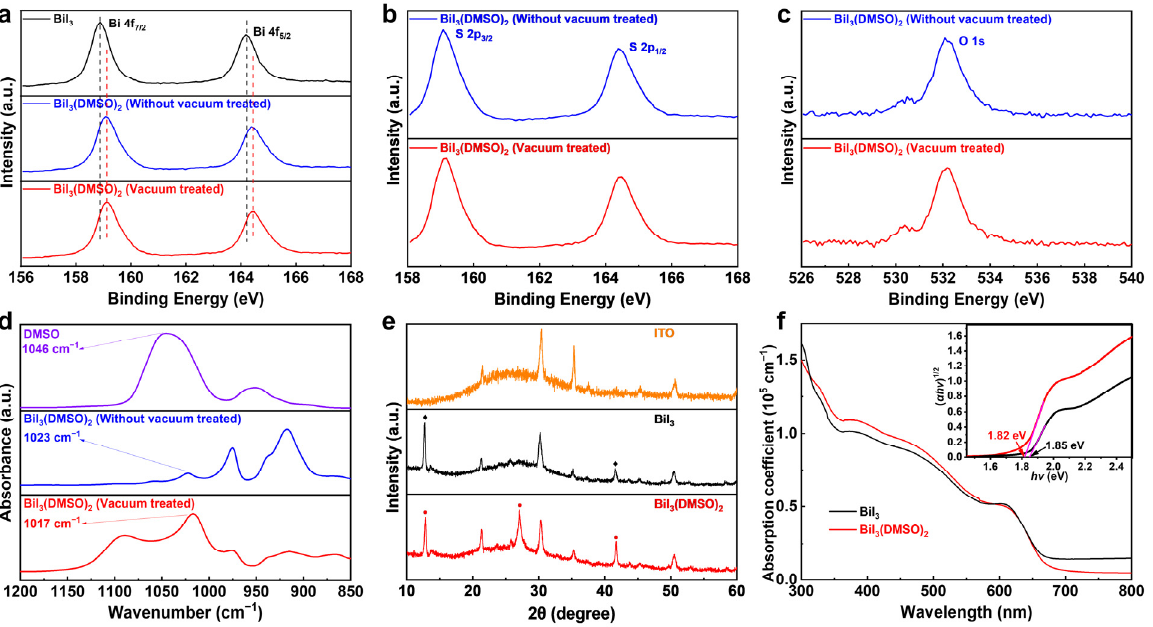
Figure 2. High-resolution XPS spectra for ( a ) Bi 4f of BiI 3 film, DMSO-coordinated BiI 3 film w/o and with vacuum treatment. ( b ) S 2p and ( c ) O 1s of DMSO-coordinated BiI 3 film w/o and with vacuum treatment. ( d ) FTIR of pure DMSO, DMSO-coordinated BiI 3 film w/o and with vacuum treatment. ( e ) XRD patterns of ITO substrate, BiI 3 films, and DMSO-coordinated BiI 3 films. ( f ) UV − Vis absorption spectra of BiI 3 films w/o and with DMSO. Inset shows the Tauc analysis of the absorption spectra.